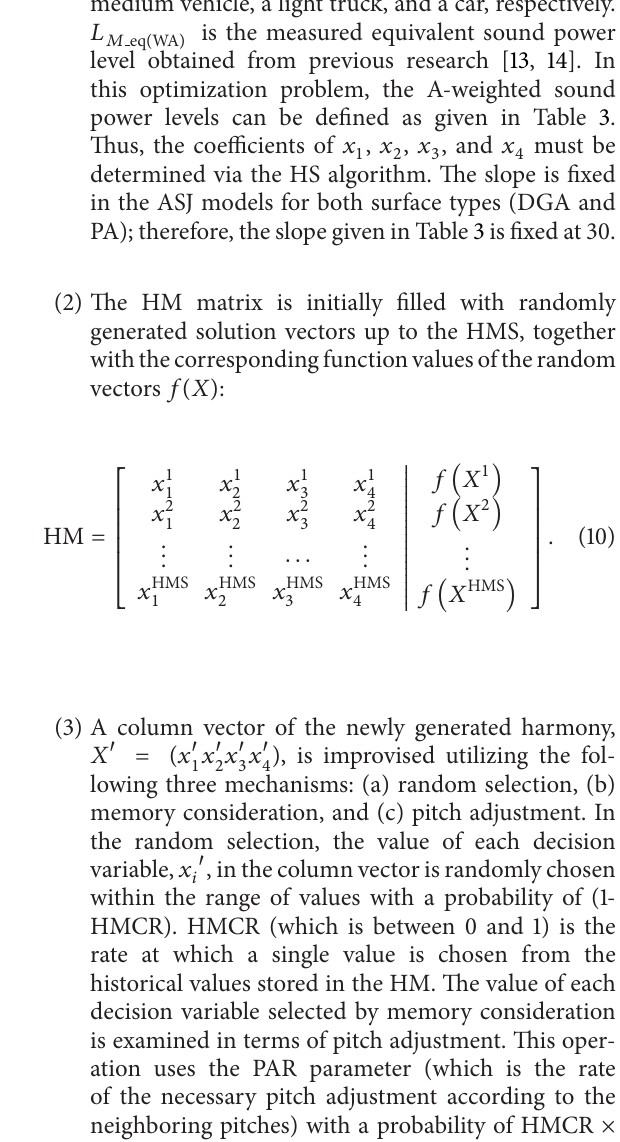
) in dB for a dense- WA